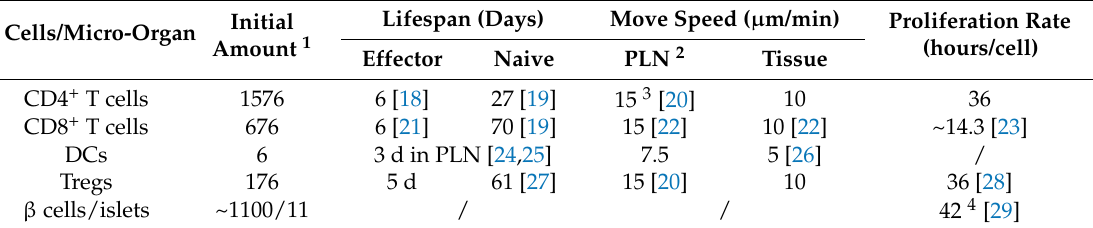
Table 1. The parameters of spaces and cell agents.